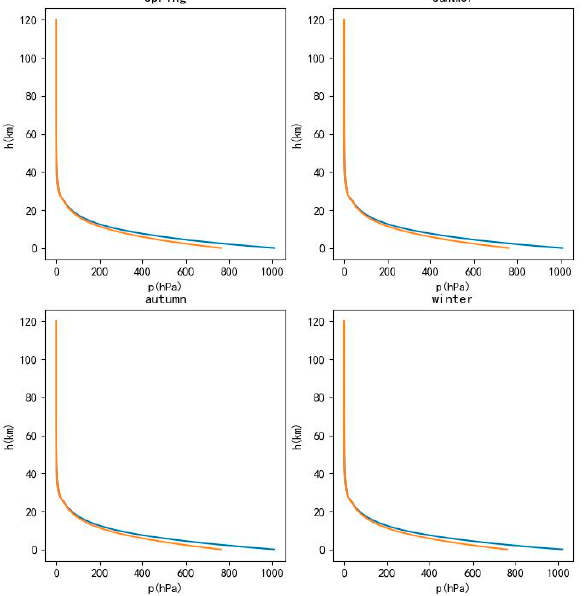
Figure 24. Pressure profile reconstruction results (yellow curve—profile before correction, blue curve—profile after correction).